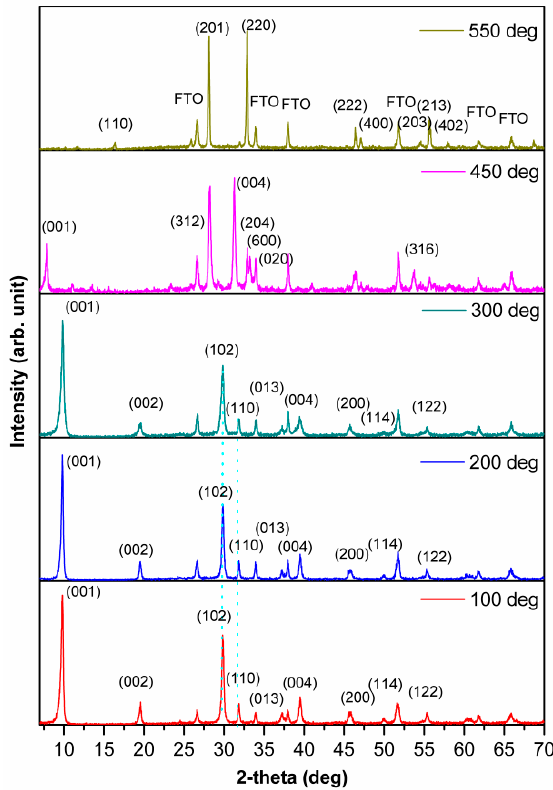
Figure 1. XRD pattern of annealed BiOI at varied temperatures: 100 °C, 200 °C, 300 °C, 450 °C, and 550 °C.